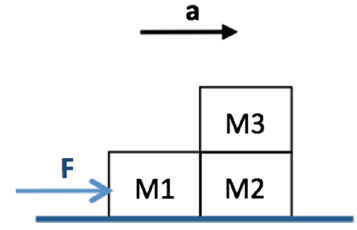
FIG. 5. Figure for friction post-test problem 1.